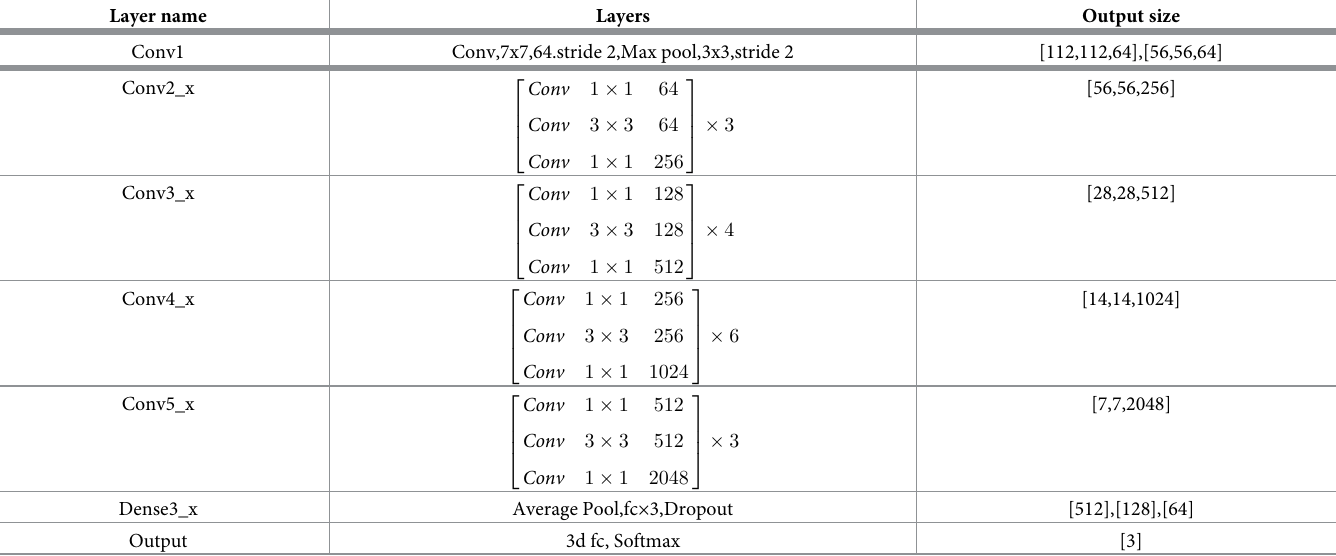
Table 3. Architecture and feature extraction process of ResNet-50 for aesthetic-aware modeling. Layer